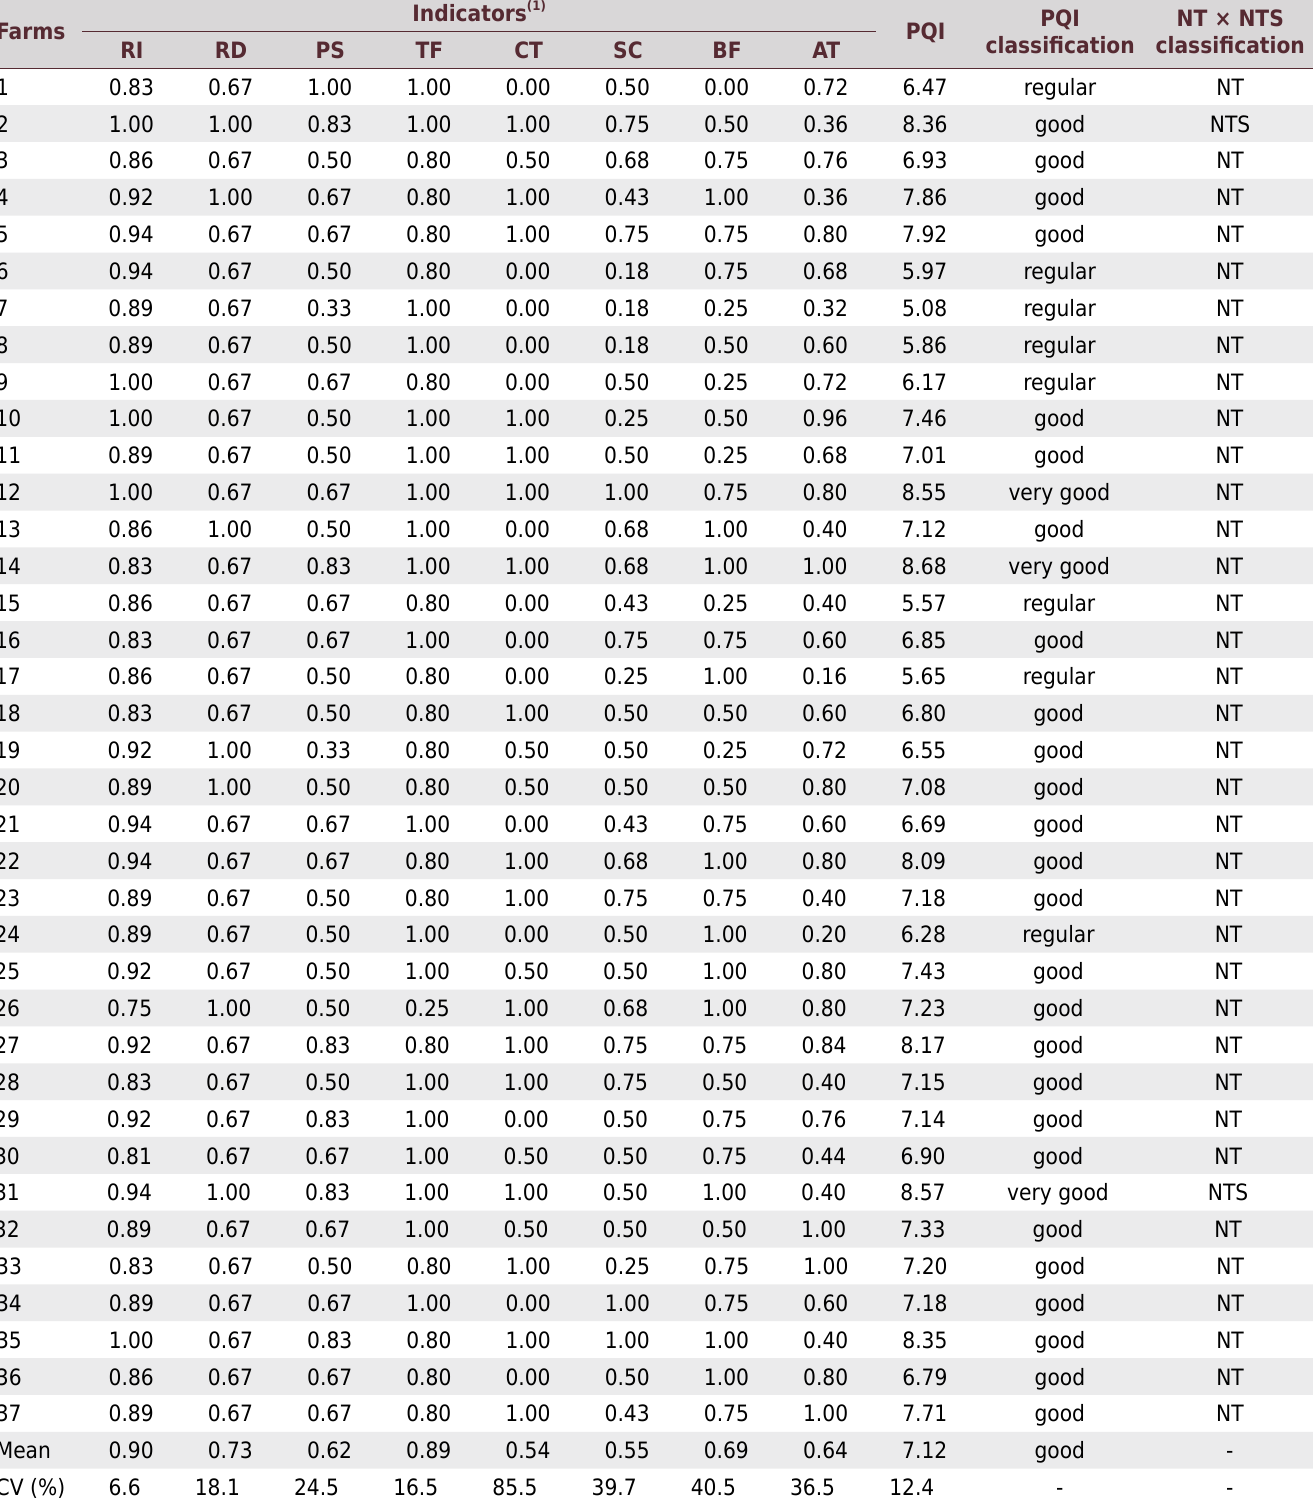
Table 4. Values of indicators, PQI values, and classifications as no-tillage (NT) or no-tillage system (NTS) in each farm evaluated